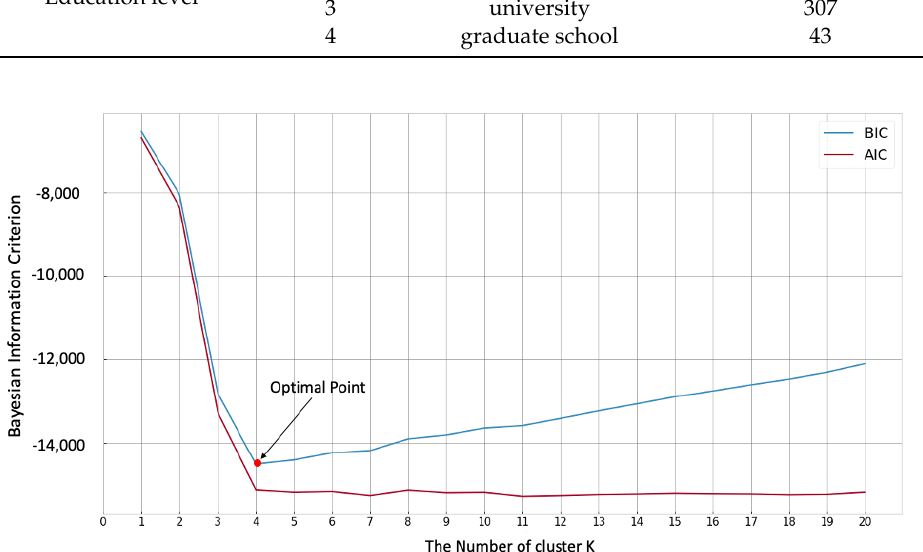
Figure 3. BIC and AIC of residential customers clustered using GMM.